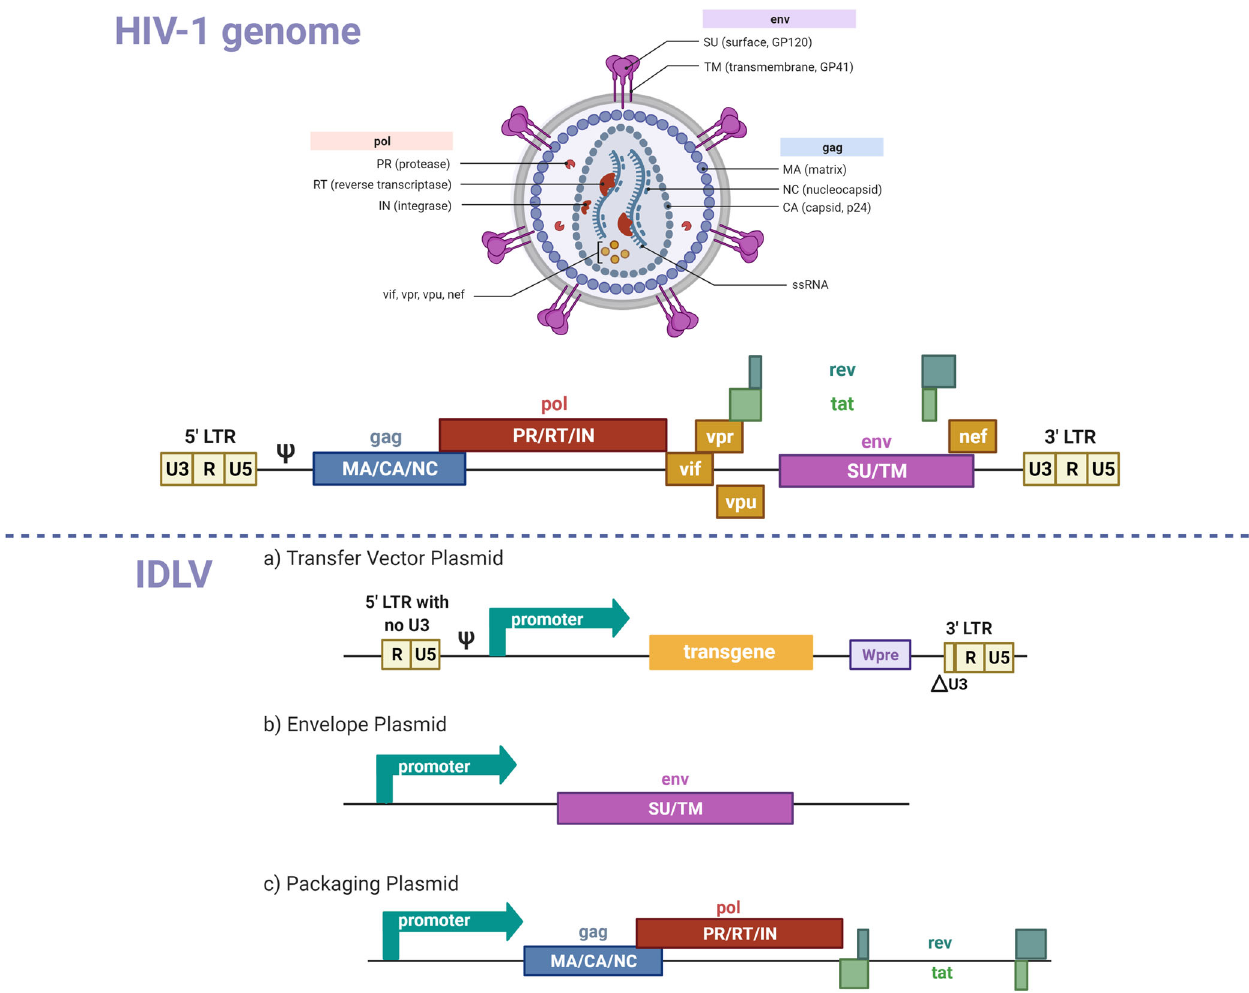
Fig. 4 A schematic overview of the lentiviral vector system. The HIV-1 virion and genome are included in the top panel for reference. a Transfer Vector Plasmid : this plasmid combines the 5 ’ and 3 ’ long terminal repeats (LTRs), and psi component of the HIV-1 genome, along with a promoter, transgene, and the woodchuck hepatitis virus regulatory element (Wpre). The full deletion of the U3 (unique 3 ’ end) region in the 5 ’ LTR and partial deletion of the U3 region in the 3 ’ LTR renders the vector self-inactivating (SIN). b Envelope plasmid: this plasmid contains a promoter to drive the expression of the VSV-G envelope protein (env) used to pseudotype lentiviral vector particles. c Packaging plasmid: This plasmid contains a promoter to drive expression of the group speci fi c antigen (gag), DNA polymerase (pol), rev, and trans- activator of transcription (tat) elements of the HIV-1/SIV